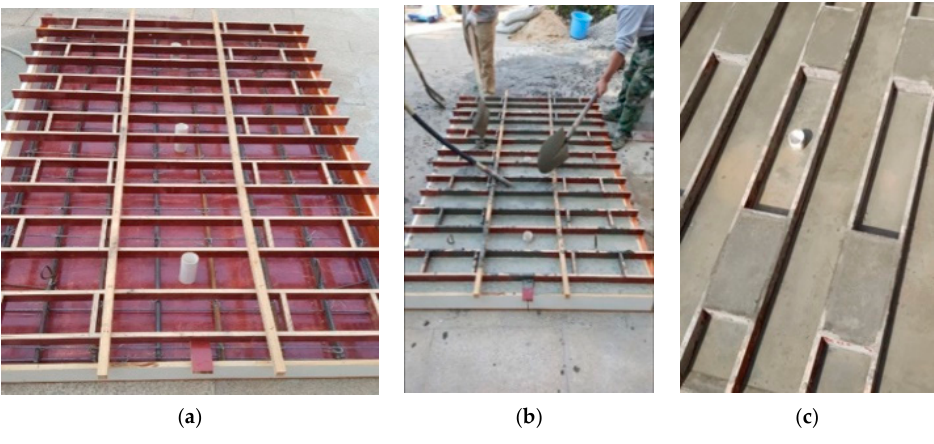
Figure 4. ( a ) Reinforcing bar setting; ( b ) Casting processing; ( c ) Casted slab track plate. Figure 5. ( a ) Reinforcing bar diagram; ( b ) Newly designed slab track plate; ( c ) Normal slab track plate (mm).